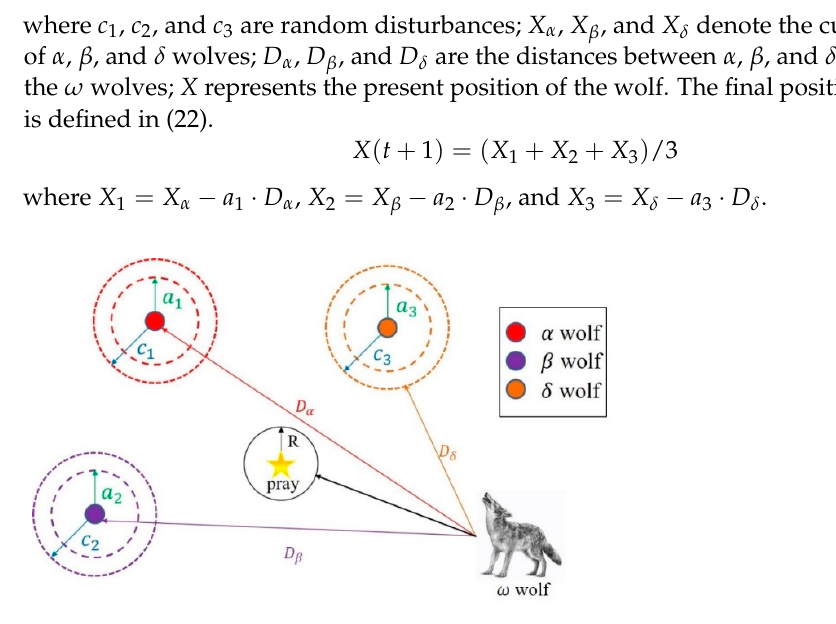
Figure 10. Grey wolf social hierarchy.